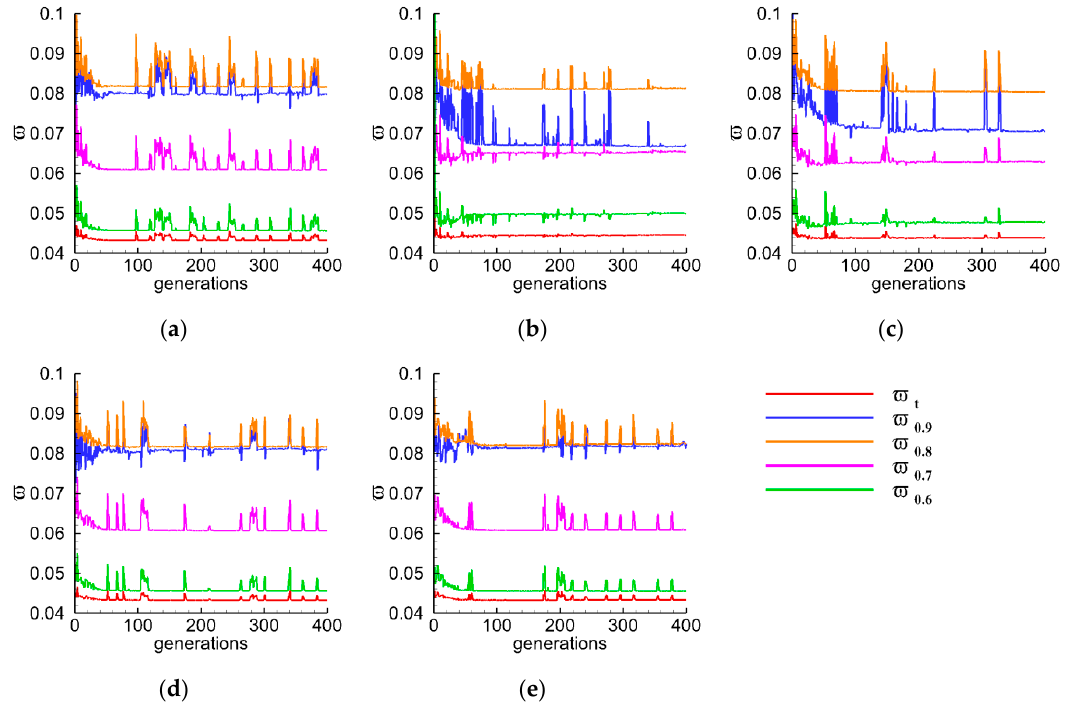
Figure 16. Changes of different losses during the process of the SPEW optimization with different schemes. ( a ) Scheme s1; ( b ) scheme s2; ( c ) scheme s3; ( d ) scheme s4; ( e ) scheme s5. Table 4. Correlation factors of each loss coefficients under different optimization schemes. ( a )